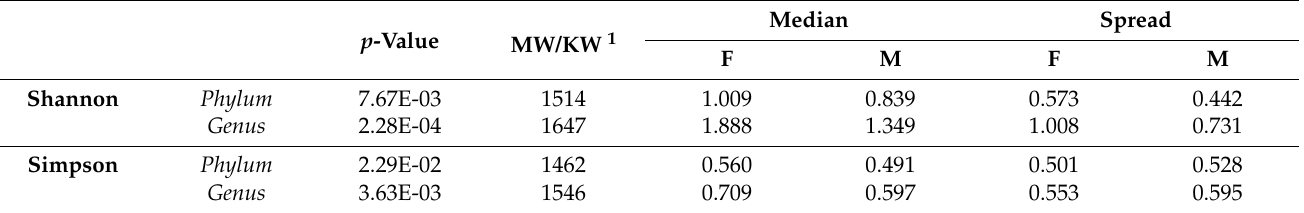
Table 2. Values of interest at the phylum and genus levels, calculated from Shannon and Simpson indexes.